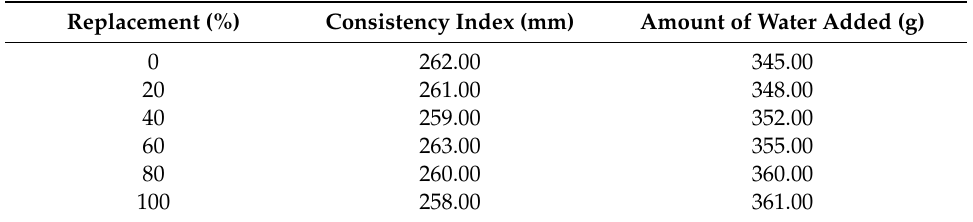
Table 5. Result of the amount of standard water in each mortar, through the consistency